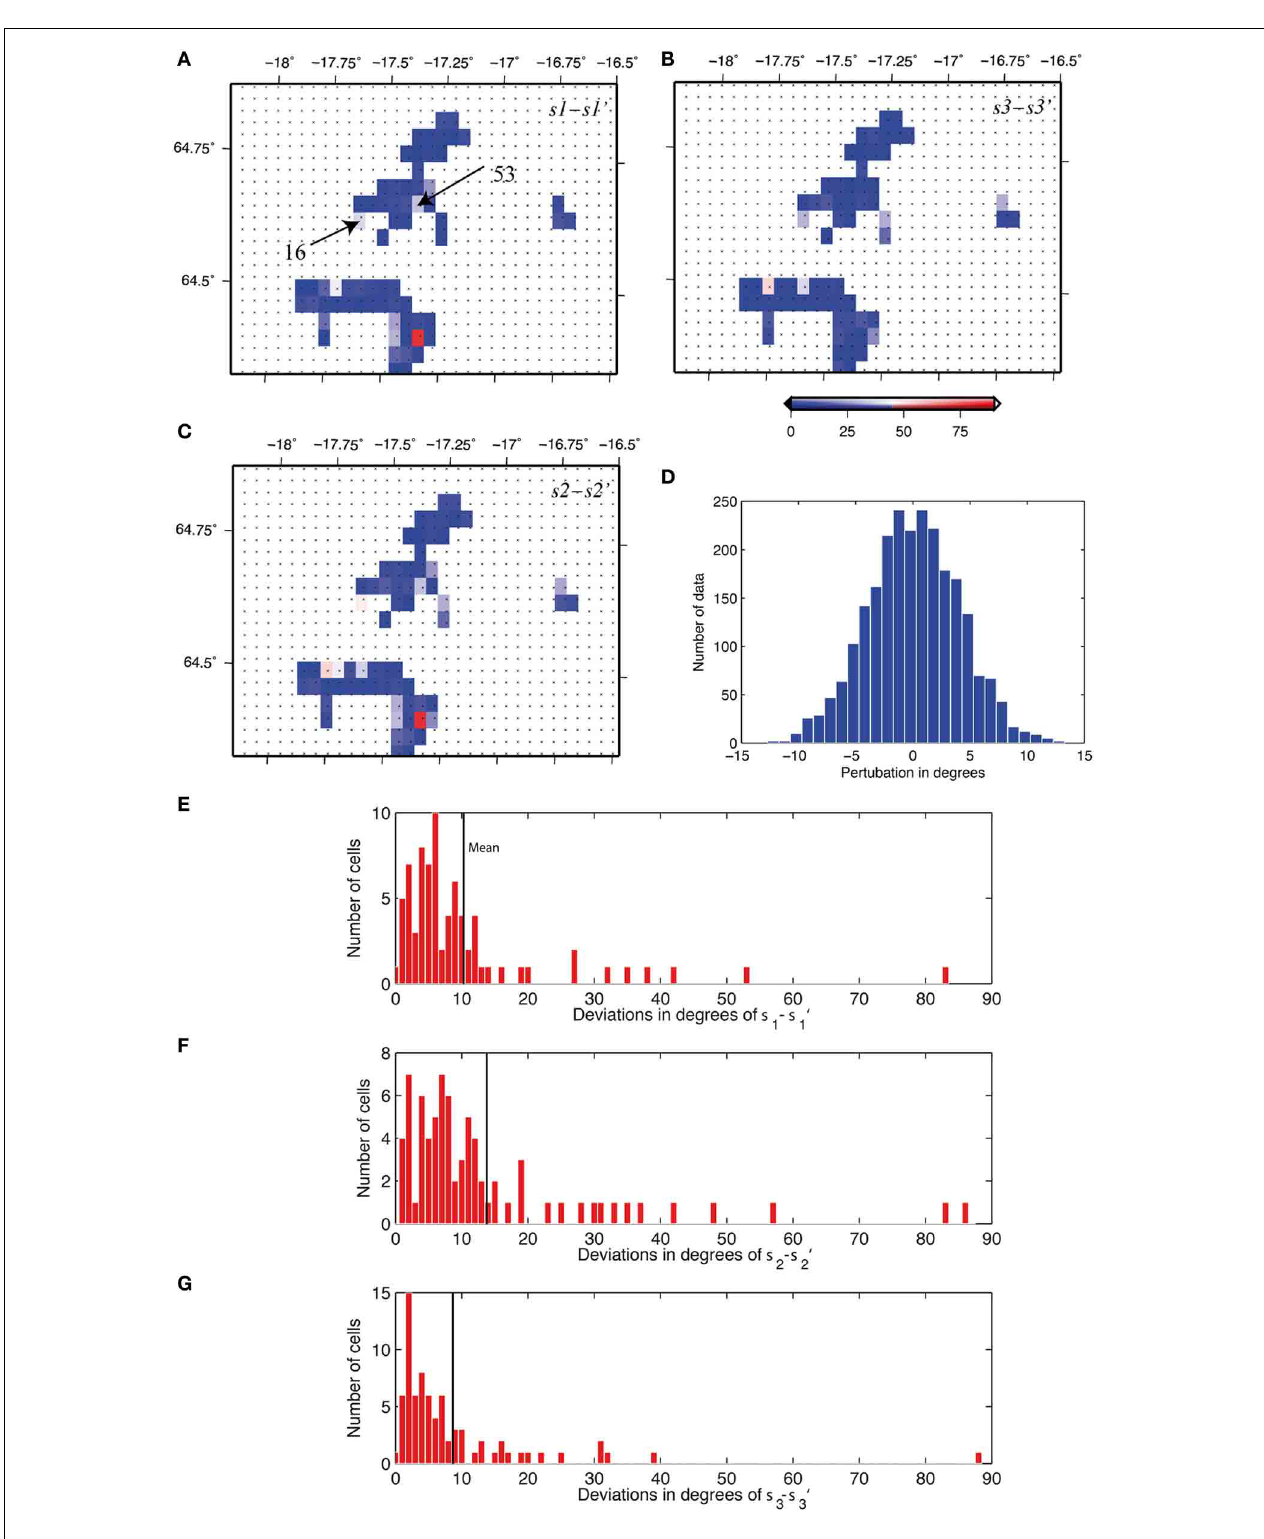
FIGURE 7 | Results for error propagation tests. (A–C) represent the surface map of the angular deviation in degrees indicated by the color bar scale for (cid:4) σ 1 − (cid:4) σ (cid:6) 1 , (cid:4) σ 2 − (cid:4) σ (cid:6) 2 , and (cid:4) σ 3 − (cid:4) σ (cid:6) 3 respectively. Cells 53: example of stress axes permutation between (cid:4) σ 1 and (cid:4) σ 2 while (cid:4) σ 3 remains unchanged